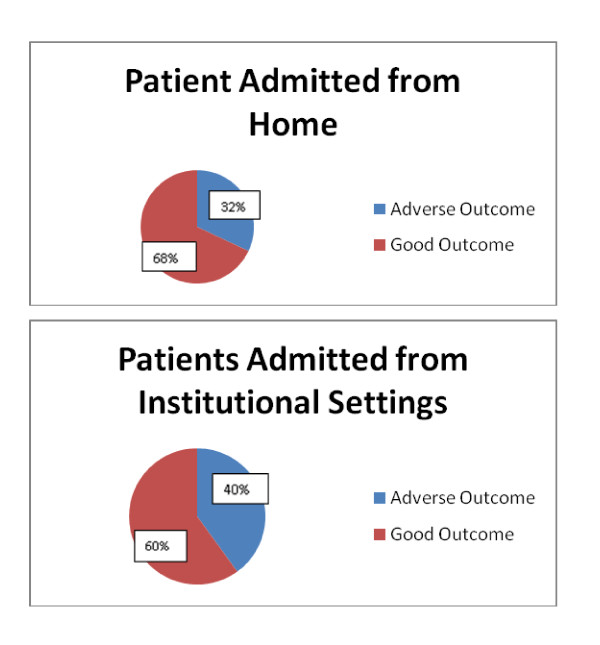
Preadmission residence against patient outcome.